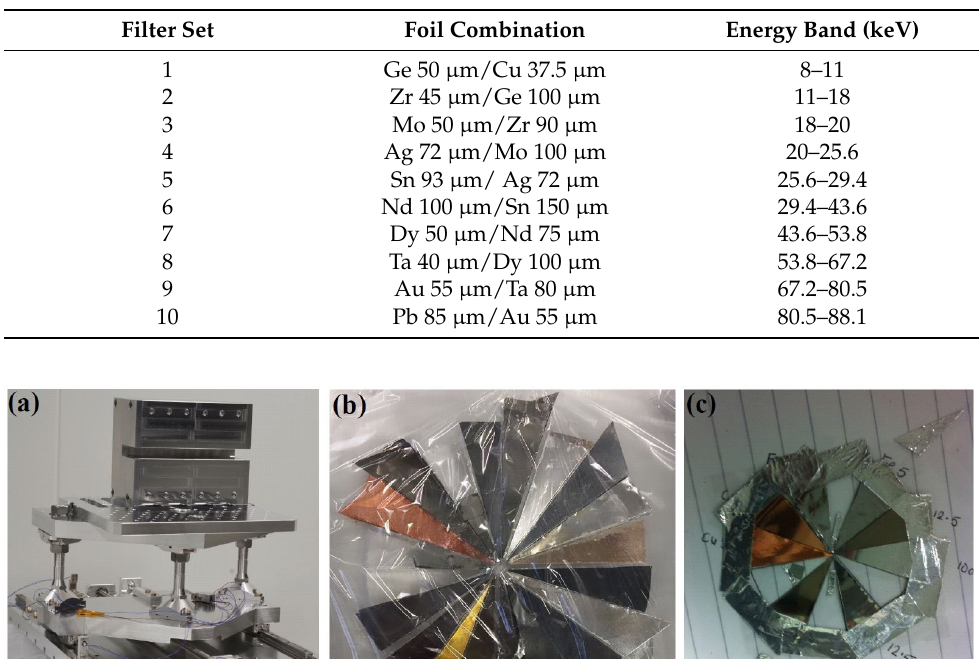
Table 1. The ELI high-energy Ross-filter-based spectrometer and its filter combination to cover the 8–88 keV spectral range.